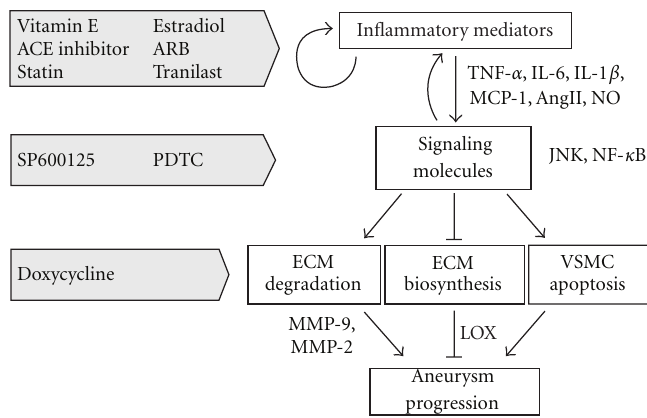
Figure 2: Pathogenesis of abdominal aortic aneurysm (AAA) with potential therapeutic drugs. Intracellular signaling molecules are activated by several types of proinflammatory mediators, while activated signaling pathways also enhance inflammatory mediators. Moreover, the activated signaling molecules shift the balance of extracellular matrix metabolism toward degradation, leading to AAA progression. Pharmacologic agents targeting each aspect of the pathological processes are demonstrated. ACE: angiotensin converting enzyme; ARB: angiotensin II receptor blocker; PDTC: pyrrolidine dithiocarbamate; TNF: tumor necrosis factor; IL: interleukin; MCP: monocyte chemoattractant protein; Ang: angiotensin; NO: nitric oxide; JNK: c-jun N-terminal kinase; NF: nuclear factor; MMP: matrix metalloproteinase; LOX: lysyl oxidase; ECM: extracellular matrix; VSMC: vascular smooth muscle